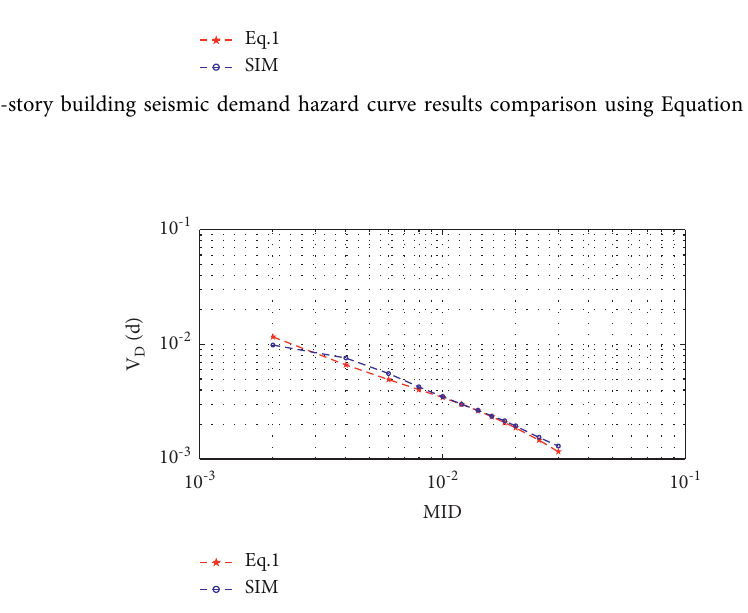
Figure 17: 8-story building seismic demand hazard curve results comparison using Equation (1) and ANN model.